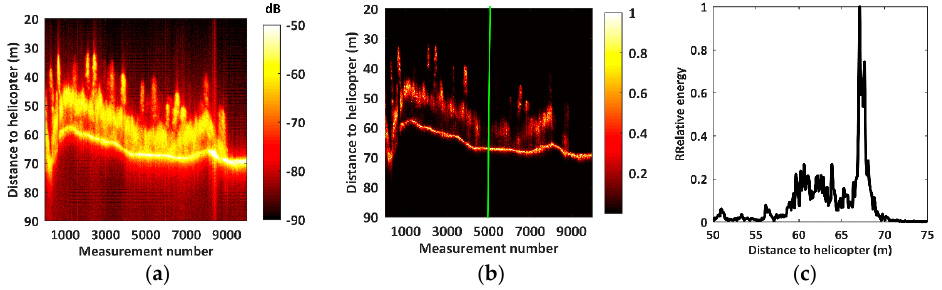
Figure 2. ( a ) Raw Tomoradar waveform profiles in one stripe in HH mode; ( b ) normalized power waveforms converted from raw Tomoradar waveforms; ( c ) a single power waveform at the green line location of the power waveforms. All raw Tomoradar waveforms are scaled from 20 m to 90 m for better illustration, even though they were recorded from 10 m to 150 m. The power waveform is normalized by its corresponding maximum of each measurement.